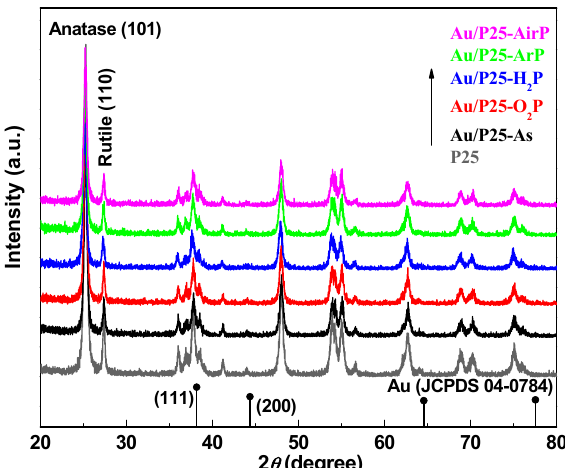
Figure 2. X-ray diffraction (XRD) patterns of the Au/P25 catalysts as prepared and activated by AP cold plasma using various working gases, as well as P25 support.